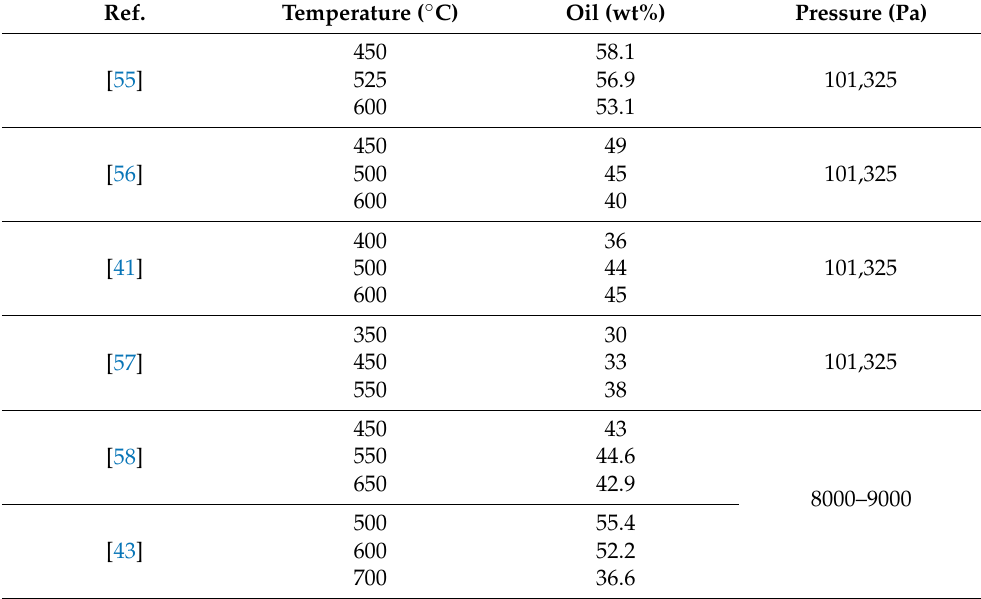
Table 1. Oil production at different pyrolysis temperatures.